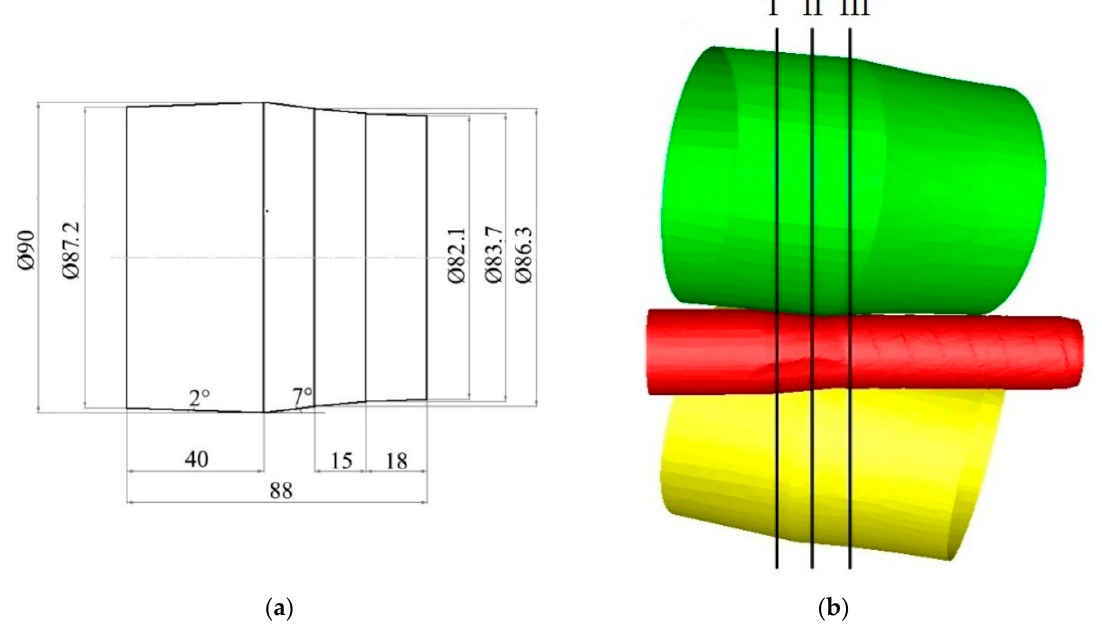
Figure 3. The shape and dimensions of the rolls ( a ) and the scheme of their arrangement in the rolling mill working space ( b ).